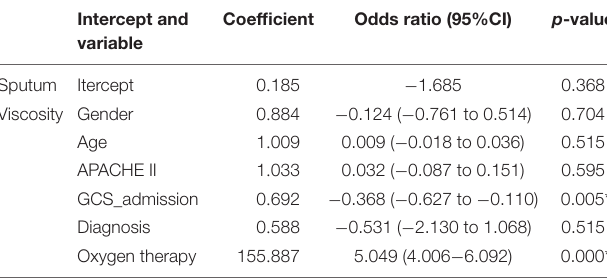
TABLE 5 | Logistics regression analysis of sputum viscosity.